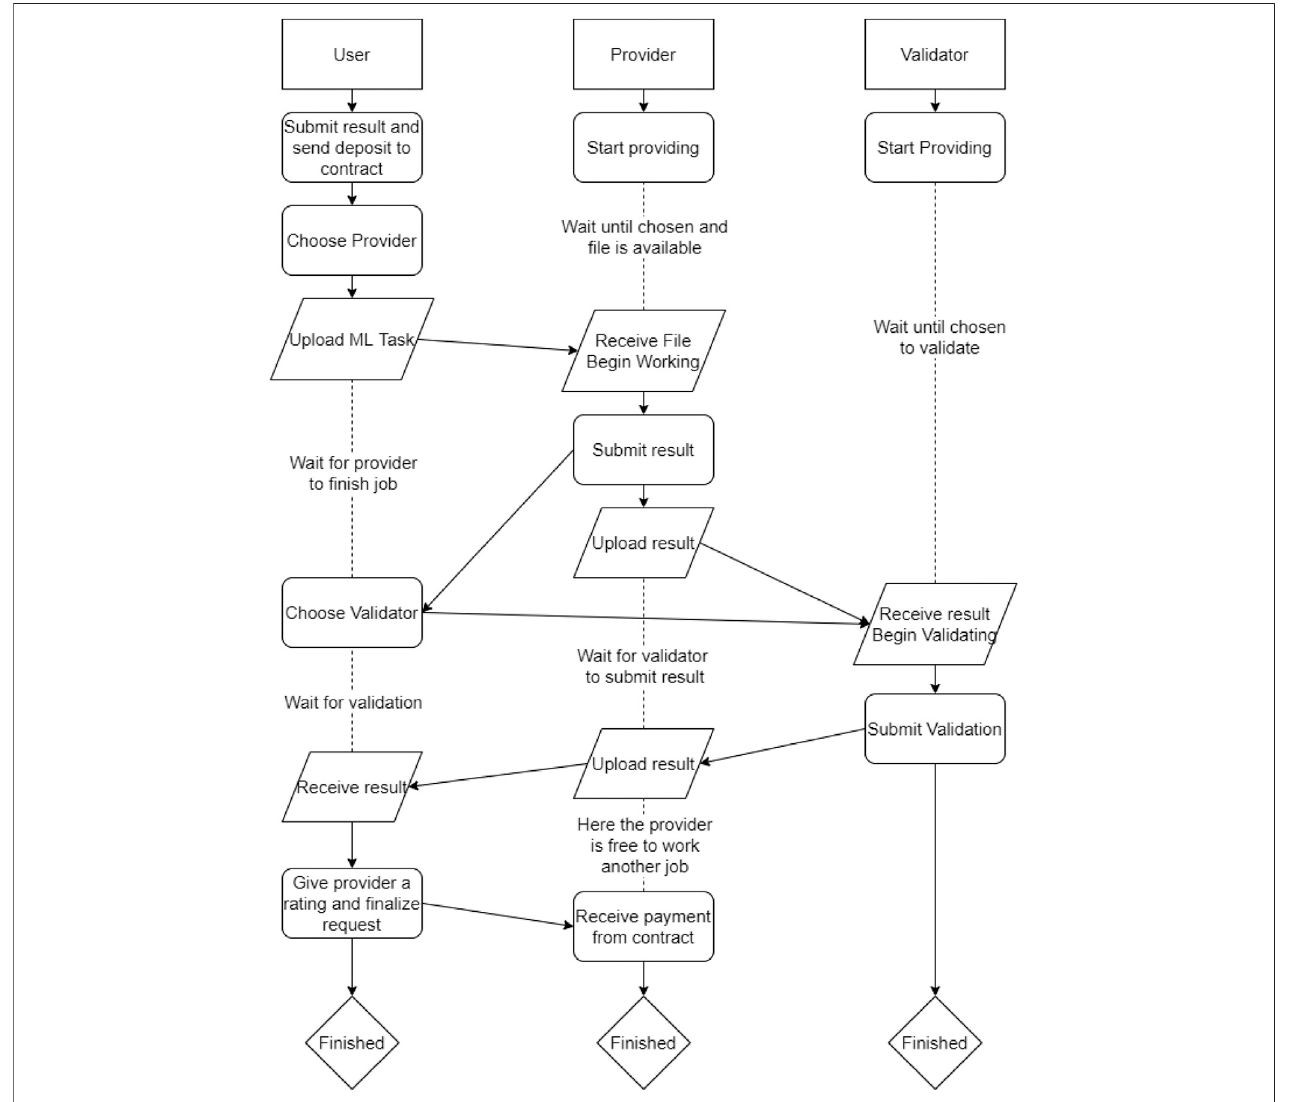
FIGURE 5 | Execution diagram to complete